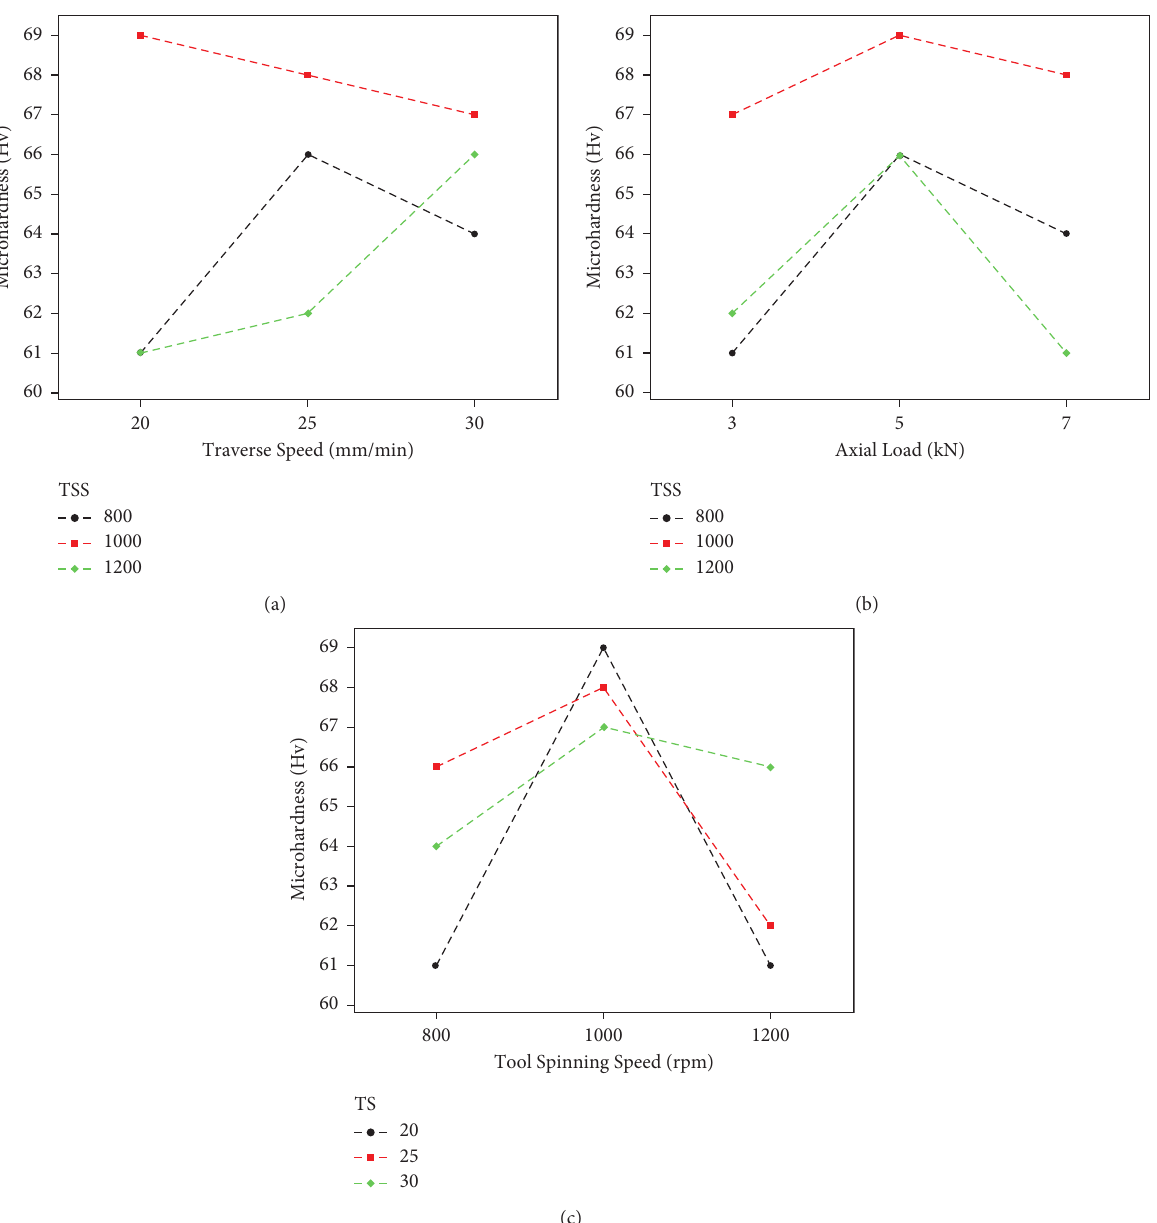
Figure 7: Interaction plots of microhardness for (a) tool spinning speed versus traverse speed, (b) tool spinning speed versus axial load, and (c) traverse speed versus tool spinning